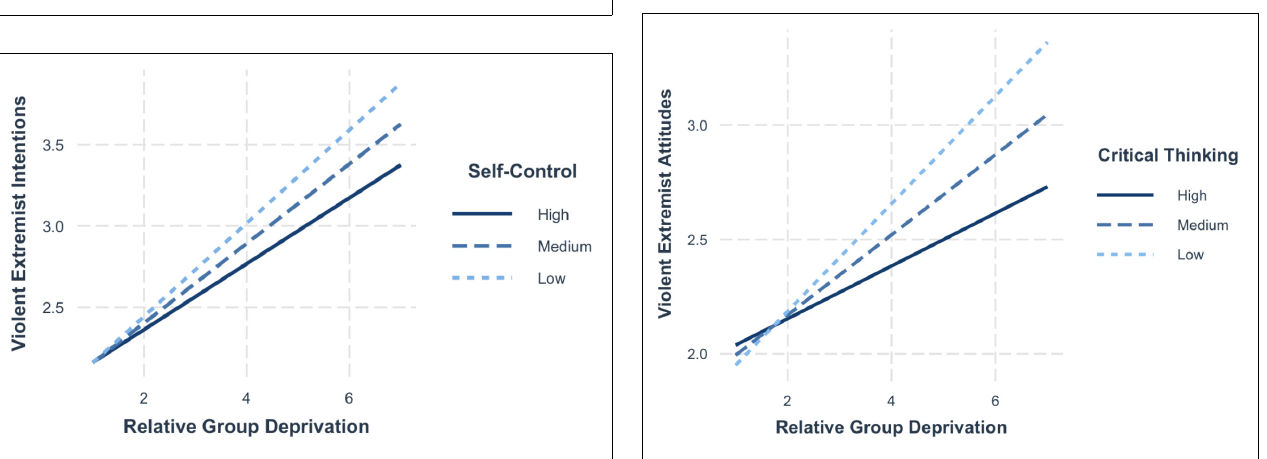
FIGURE 7 | Simple slopes for group deprivation and self-control on violent extremist intentions.